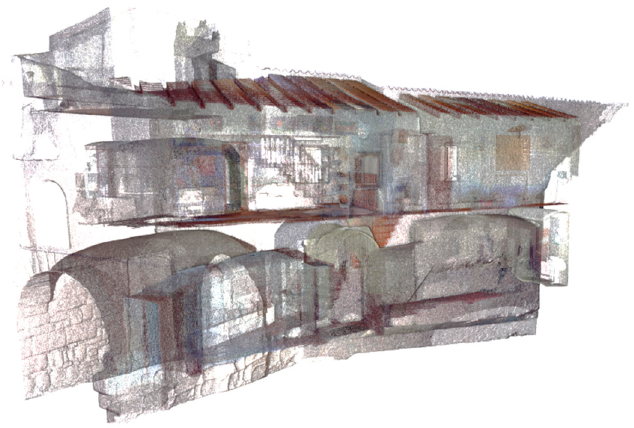
Figure 6. The methodology developed to elaborate the general mesh of the project allows for including the survey of the interior point cloud of the palaces and buildings they are carried out.